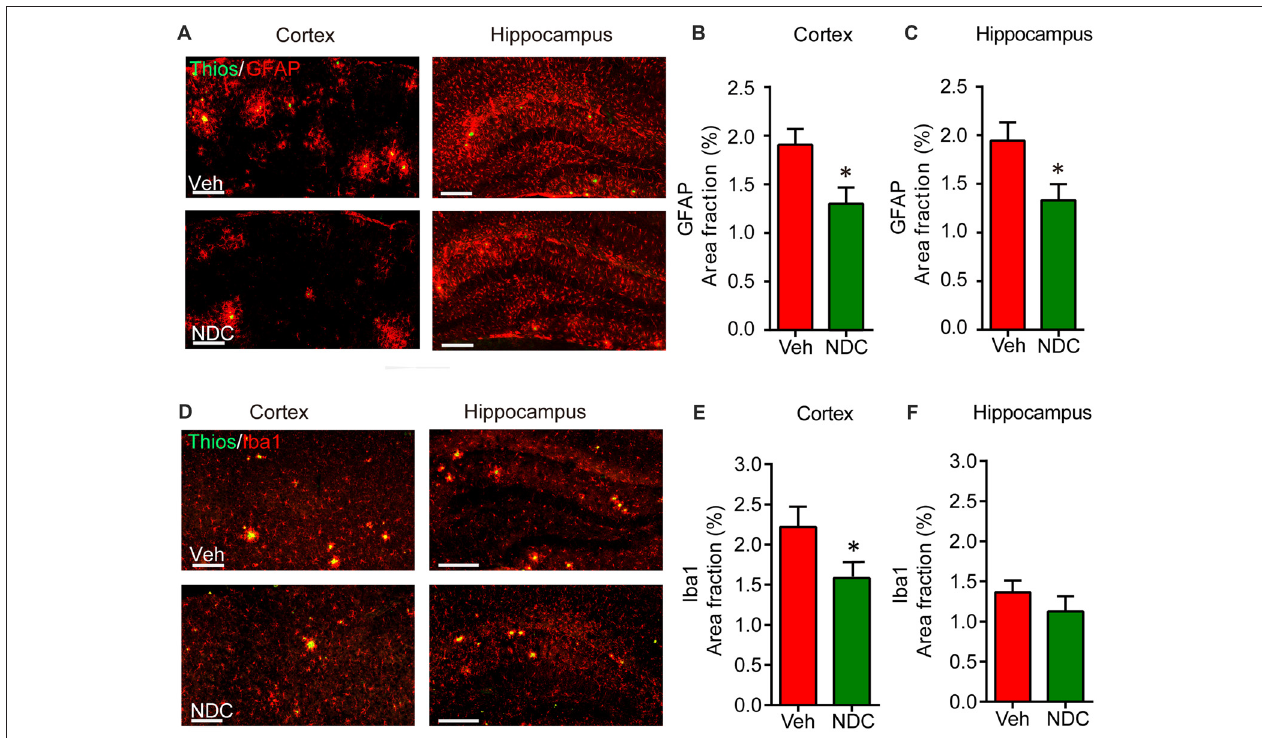
FIGURE 5 | NDC reduces periplaque activated microglia and astrocytes in APP/PS1 mice. (A) Representative sections of vehicle- and NDC-treated APP/PS1 mice brain immunostained with ThioS and GFAP in cortex and hippocampus are shown. Scale bar = 200 µ m. (B,C) Quantitative analysis of ThioS and GFAP double staining in cortex (B) and hippocampus (C) . (D) Representative sections of vehicle- and NDC-treated APP/PS1 mice brain immunostained with ThioS and microglial makers Iba1 in cortex and hippocampus are shown. Scale bar = 200 µ m. (E,F) Quantitative analysis of ThioS and Iba1 double staining in cortex (E) and hippocampus. (F) Data are presented as mean ± SEM, n = 5 per group, ∗ p < 0.05, analyzed by two-tailed t -test compared with APP/PS1 vehicle